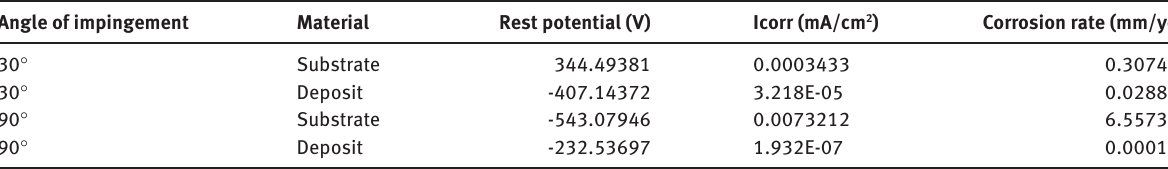
Table 4: Corrosion parameter of substrate and deposit material. Angle of